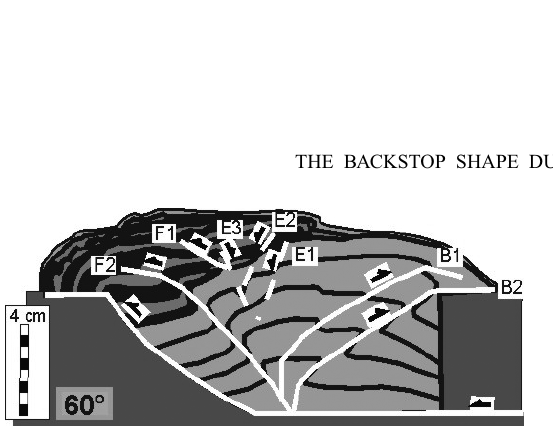
Fig. 11 – Line drawing of a cross-section cut through the central region of model 9: end result. E1-E3 are normal faults formed during exten- sional steps; F1 and F2 are forethrusts, and B1 and B2, backthrusts. Dashed and continuous lines represent extensional and contractional structures, respectively.